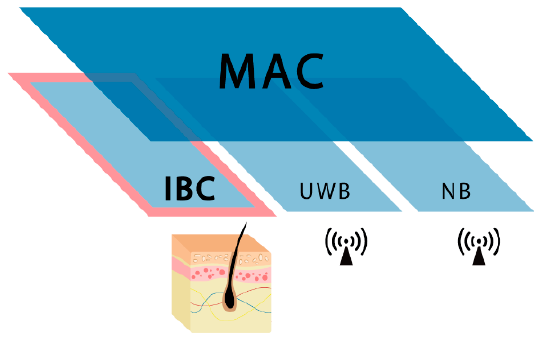
Figure 1. IEEE 802.15.6 MAC and PHY layers.